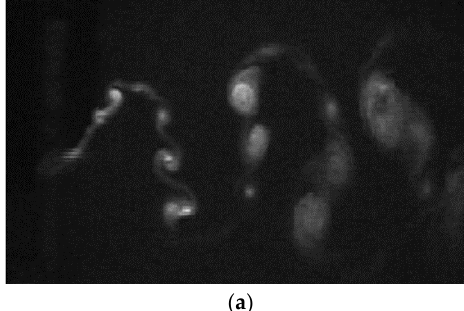
Figure 9. Vorticity pattern visualized in the foil wake for 𝑆 𝑡 = 0.45 , 𝛼 𝑚𝑎𝑥 = 20° . ( a ) Experimental results of Schouveiler et al. 2005 [43]. ( b ) Numerical results in the current work.